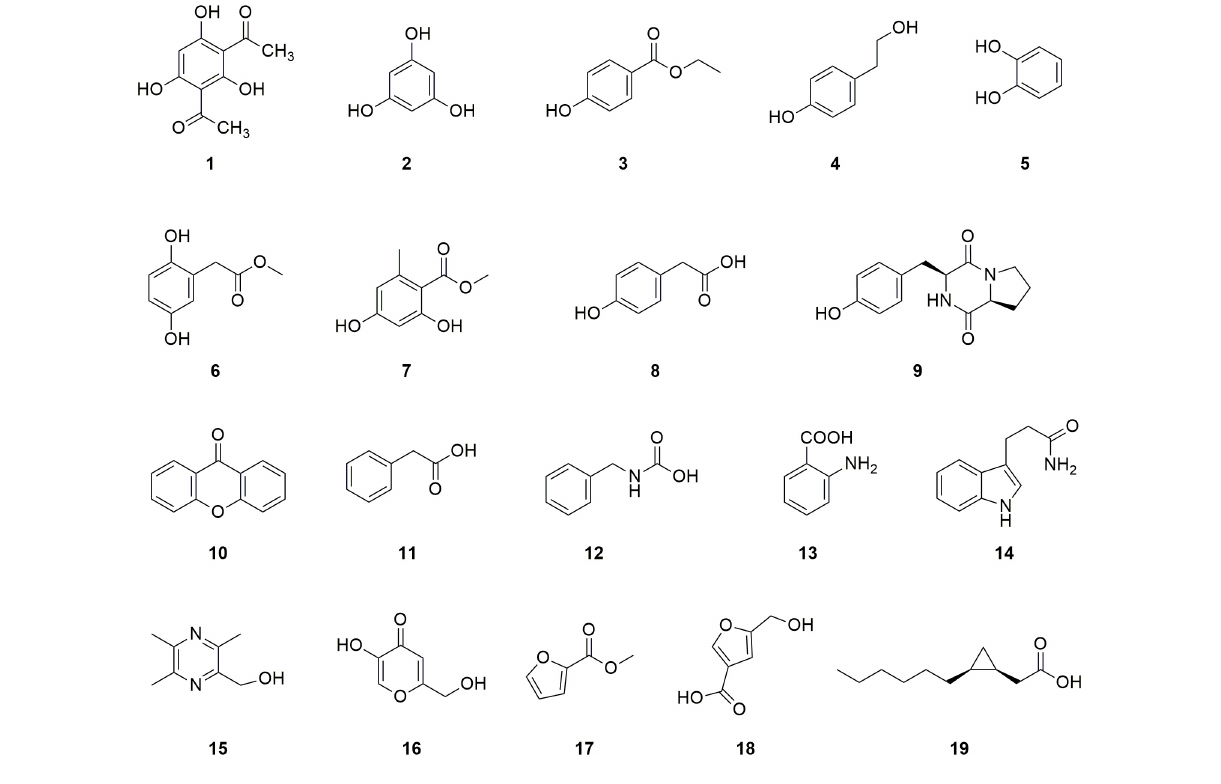
FIGURE 5 | Structure of compounds 1–19 . TABLE 1 | Antifungal activity of extracts from the fermentation broth of the bacteria isolated from Polyporus umbellatus . Pathogenic fungi Water fraction (cm) Ethyl acetate fraction (cm) Methanol fraction (cm) Ketoconazole (cm) 1.50 ± 0.14